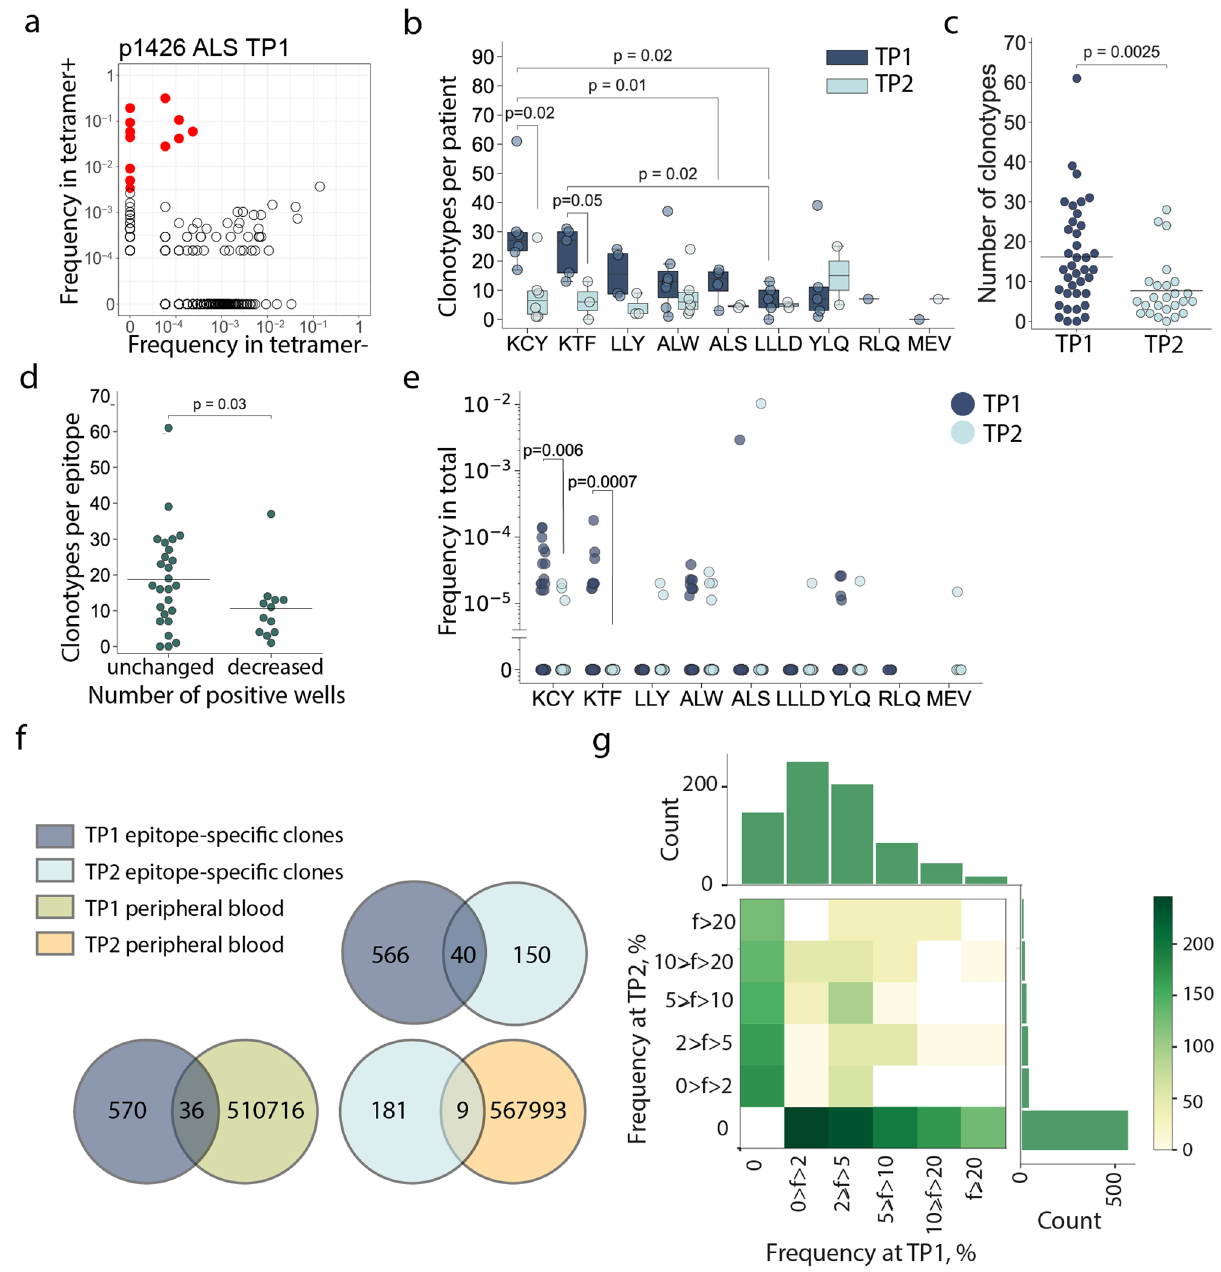
Fig. 3 Clonal structure of the SARS-CoV-2 epitope-speci fi c T-cell response. a MHC-tetramer + CD8 + cells were subjected to fl uorescence-activated cell sorting (FACS) after rapid in vitro peptide-induced expansion of PBMCs from CP ( n = 14), and their TCR β repertoire was sequenced. A representative enrichment plot is shown for patient p1426, epitope ALS at TP1. Frequencies of CDR3 β sequences in the MHC-tetramer - and the MHC-tetramer + populations are plotted. Red dots represent clonotypes that are strongly (>10-fold) and signi fi cantly ( p < 10 − 12 , Fisher ’ s exact test) enriched in the MHC- tetramer + population; b numbers of speci fi c clonotypes for each epitope at TP1 (dark blue, n = 36) and TP2 (light blue, n = 25). Boxplots show the fi rst and third quartiles with median; whiskers show 1.5 interquartile range values; c number of epitope-spe c i fi c clonotypes in the CP cohort, where each dot represents a unique patient-epitope combination (medians are shown). TP1 - dark blue, n = 36 and TP2 - light blue, n = 25; d number of speci fi c clonotypes per epitope at TP1 which exhibited an unchanged ( n = 26) or decreased ( n = 13) overall response at TP2; e frequency of epitope-speci fi c clonotypes in PBMC at TP1 (dark blue) and TP2 (light blue); f Venn diagrams showing overlap between different clonotype fractions from the CP cohort; g frequency ( f ) of epitope-speci fi c clonotypes in expansions performed at the two time-points. Color represents the number of clonotypes in each bin. Mann – Whitney p values are shown only where signi fi cance was The persistence of epitope-speci fi c T cells correlates with sequences with one or two amino acid substitutions (Fig. 4a, b). response diversity . Out of the seven epitopes for which TCRs were When only a single amino acid substitution or indel was permitted, obtained from more than one donor, LLY and YLQ demonstrated 59.7% of the LLY-speci fi c clonotypes were assigned to a cluster, the highest similarity in their epitope-speci fi c CDR3 β as measured versus 10.7% and 6.2% for KTF and KCY-speci fi c clonotypes, by the share of sequences belonging to clusters formed by the respectively, which were characterized by the lowest similarity. Of